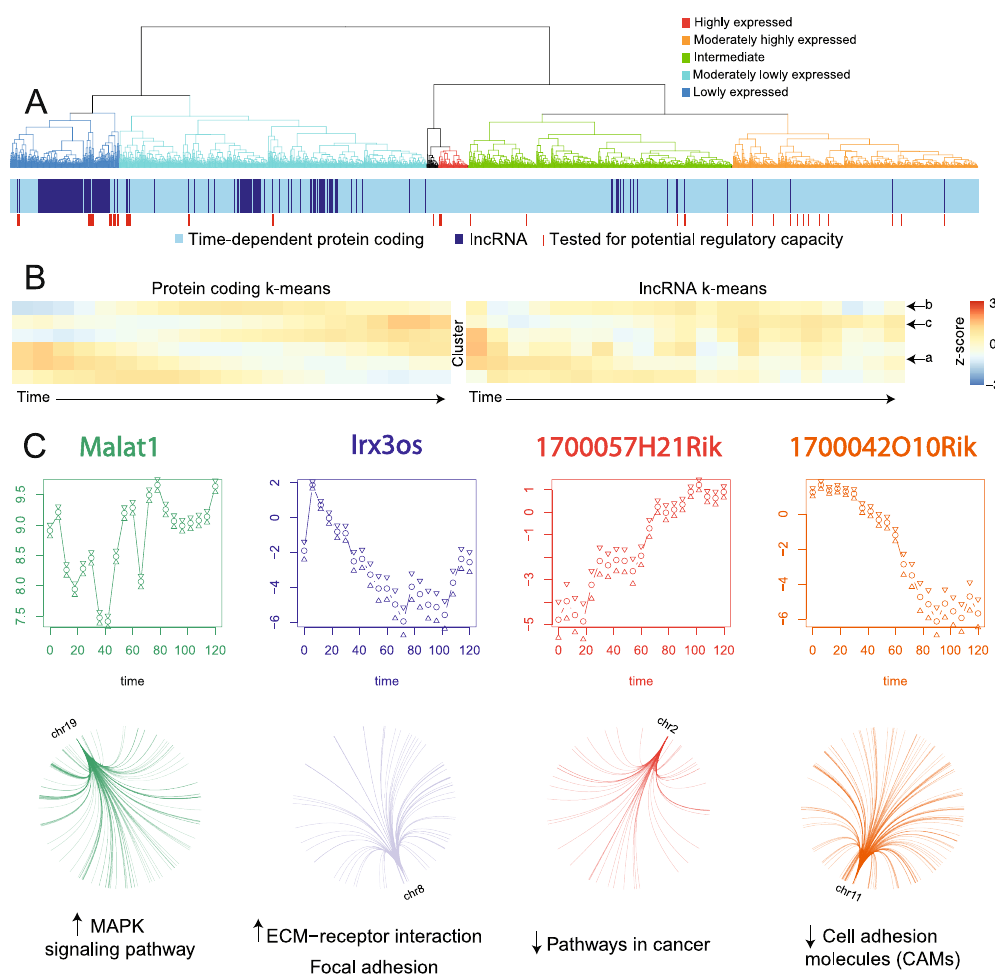
Figure 4. Augmented temporal resolution of ncRNA expression in cellular differentiation. ( A ) Hierarchical clustering of lncRNAs (dark blue) with time-dependent protein coding genes (light blue) by their expression patterns over time. Dendrogram was manually colored to reflect gene expression levels of the top-level clusters. ( B ) K-means clustered expression profiles of protein coding genes compared to the same number of lncRNA gene expression clusters. Common profiles are marked with arrows. ( C ) Expression profiles of four lncRNAs predicted to have regulatory roles in ES development as well as the genome location & pathways enriched in their gene targets. Malat1 and IRX3os display a positive association with their targets, whereas 1700057H21Rik and 1700042O10Rik have a putative repressive